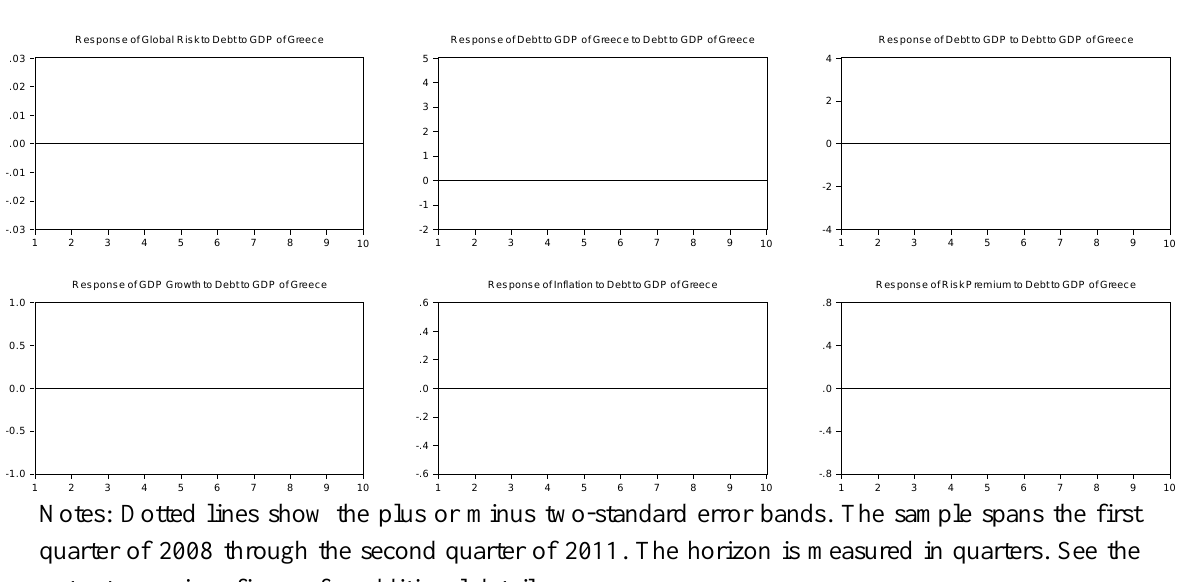
Figure 16. Response of EMU countries to a shock to Greece’s debt-to-GDP ratio during the crisis: